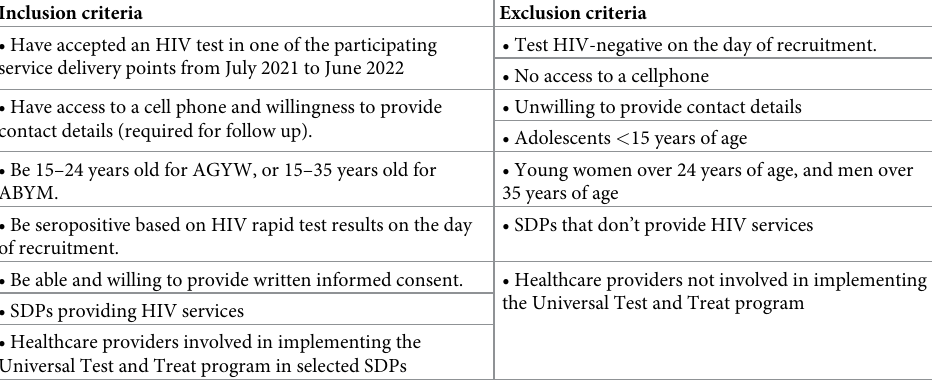
Table 1. Eligibility criteria for the SHeS’Cap-Linkage study in uMgungundlovu district, KwaZulu-Natal, South Africa, 2021–23. Inclusion